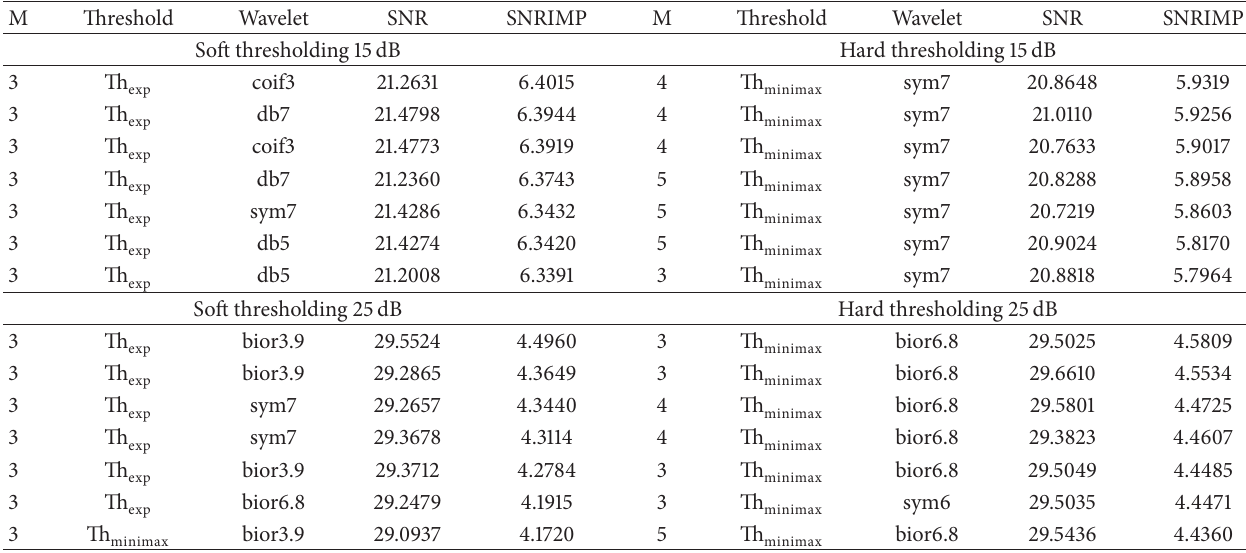
Table 2: Denoising evaluation using synthetic ECG